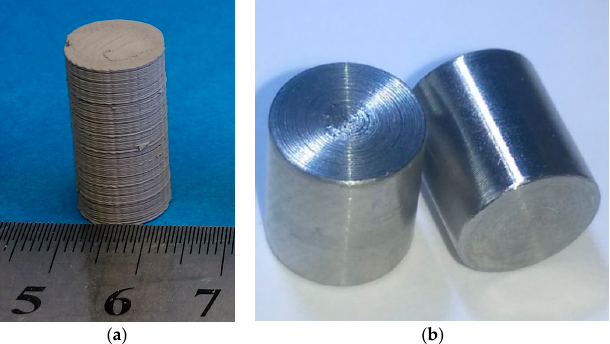
Figure 3. ( a ) Printed cylinders for geometrical and mechanical investigations; ( b ) turned cylinders for density investigation.